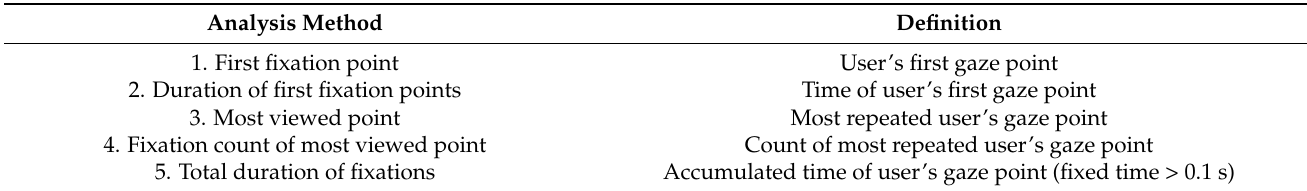
Table 2. Eye tracking analysis elements and definitions.